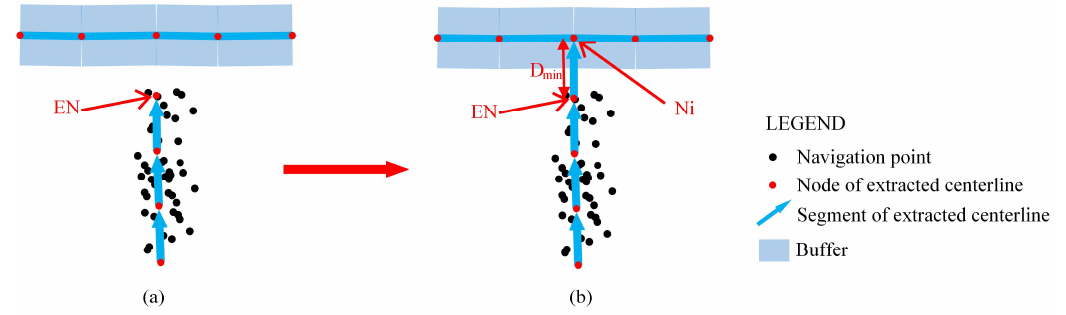
Figure 5. Relationship built between extracted centerlines. ( a ) Before building and ( b ) after building. EN is end node, D min is minimum distance, Ni is normal mode.